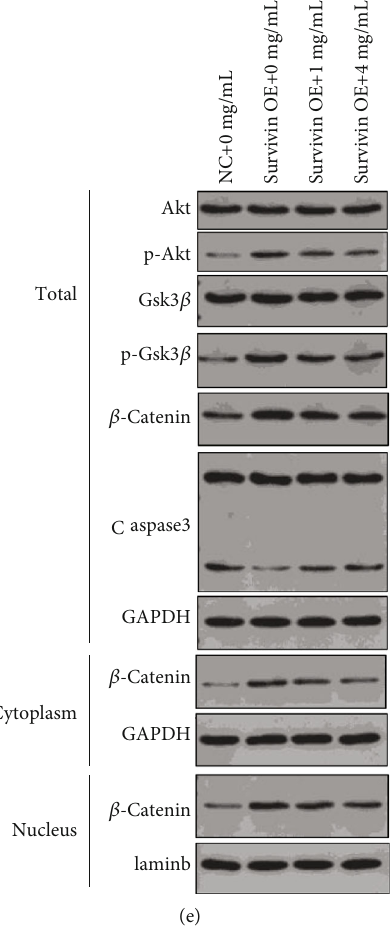
Figure 8: Western blot: the e ff ect of di ff erent concentrations of YXJD on the expression of Survivin (a), LC3II/I, and p62 (d) in HUVEC cells transfected with Survivin overexpression plasmid, and the expression of PI3K/Akt- β catenin pathway and Caspase3 (e). ELISA: the e ff ect of di ff erent concentrations of YXJD (0, 1, and 4 mg/mL, for 72h) on the secretion of VEGF in HUVEC cells transfected by Survivin overexpression plasmid (b). qRT-PCR: the e ff ect of di ff erent concentrations of YXJD on the synthesis of VEGF in HUVEC cells transfected by Survivin overexpression plasmid (c). GAPDH was used as the internal reference for cytoplasmic protein content and total protein content; Laminb as the internal reference for nuclear protein content; total stands for total protein; cytoplasm for cytoplasmic protein; nucleus for nuclear